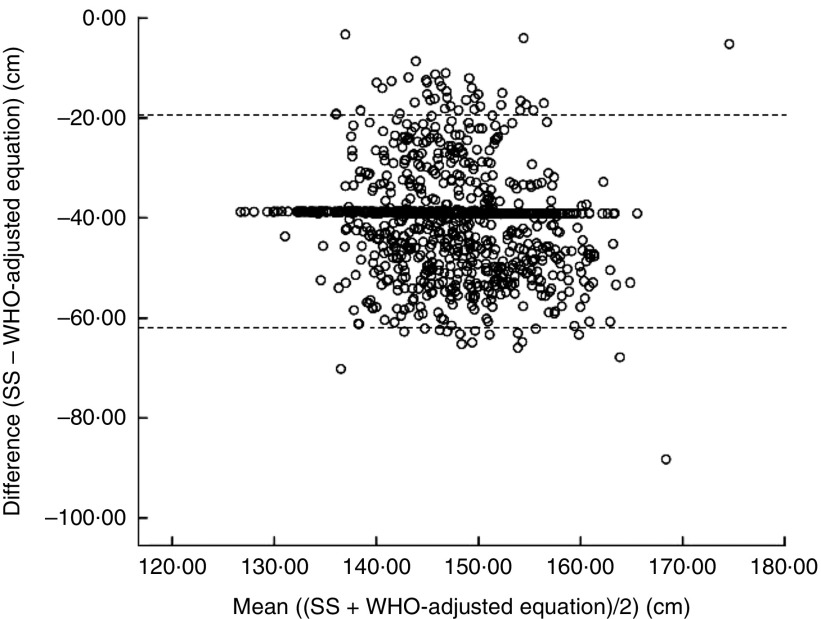
Bland–Altman plot assessing the agreement between stretch stature (SS) and the
WHO-adjusted equation for estimating true height in a convenience sample
(N 900) of young South African adults aged 18–24 years that included
equal numbers both genders stratified across race groups (Caucasian, Black African and
Indian), KwaZulu-Natal, 2015. The difference between SS and the WHO-adjusted equation
is plotted v. the mean of the two methods, where – – – – – represent
the limits of agreement